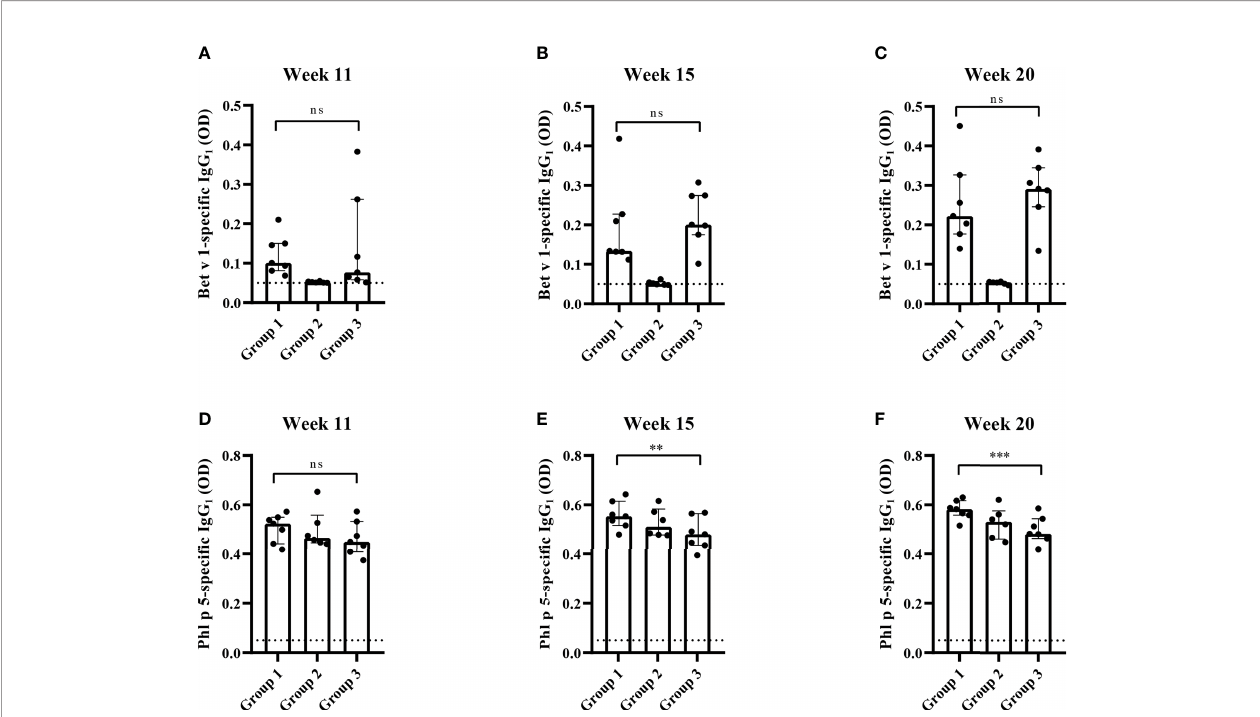
FIGURE 8 | Allergen-speci fi c IgG 1 responses after prophylactic administration of Bet v 1 peptides. Bet v 1-speci fi c IgG 1 levels in the three mouse groups at week 11 (A) , at week 15 (B) and at week 20 (C) . Phl p 5-speci fi c IgG1 levels in the three mouse groups at week 11 (D) , at week 15 (E) and at week 20 (F) . Serum levels were measured as duplicates for each mouse with deviations of less than 10% (y-axes: optical density OD levels). Results are displayed as scatter plots with group medians with interquartile ranges. Dotted horizontal bars indicate the cut-off levels for the antibody measurements. Data were analyzed by a general linear model with a log link, comparing group 1 and 3 by linear contrast. Statistically signi fi cant differences between group 1 and group 3 are indicated (***P < 0.001, **P < 0.01). ns, not signi fi